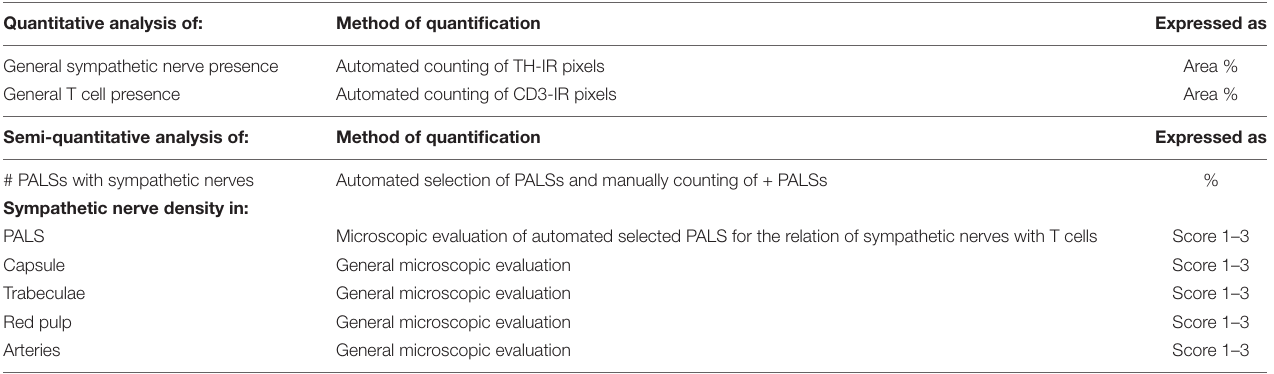
TABLE 3 | Studied parameters, their method of quantification and data